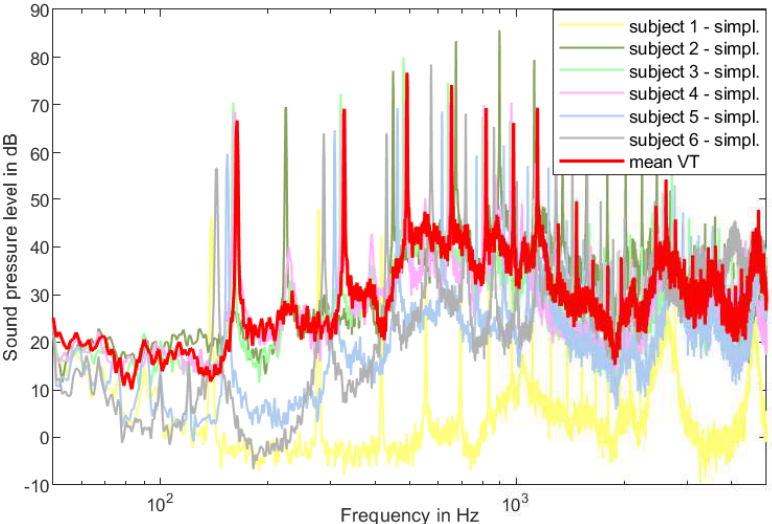
Figure 6. SPL of the sound emitted by vocal fold replicas coupled with simplified VT replicas from six subjects, based on the MRI-data by Echternach et al. [34] in comparison with the mean VT replica. The geometries of the simplified VTs are based on the cross-sectional area function of the realistic MRI-derived geometries. The simplified VT was straightened and the cross-section was designed with a circular